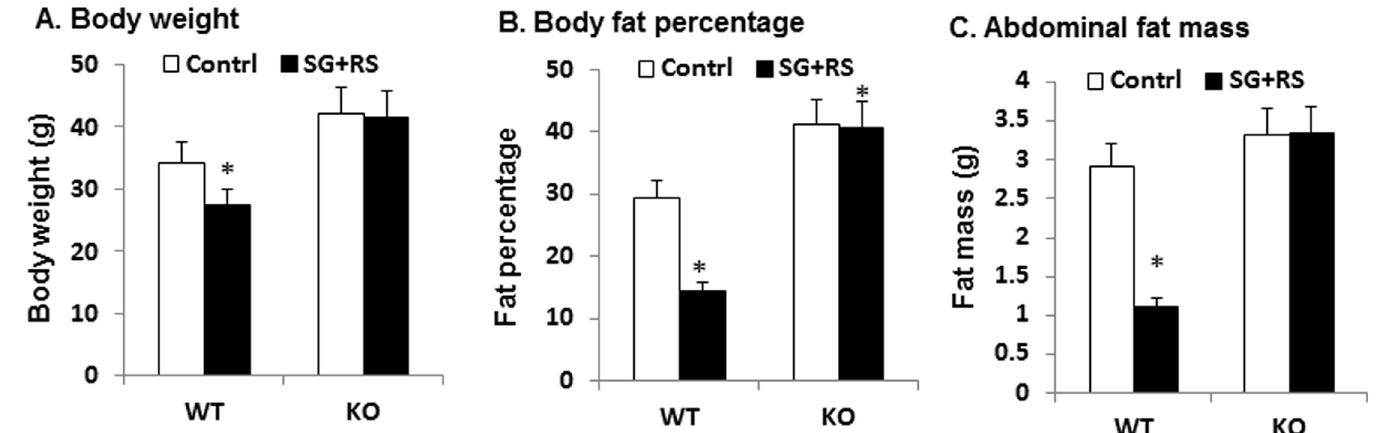
Fig 2. Body weight and adiposity in KO mice. A. Body weight of animals in response to SG and RS. B. Body fat content in percentage. C. Abdominal fat mass. The results are expressed as mean ± SEM (n = 12). * p < 0.05 treated versus